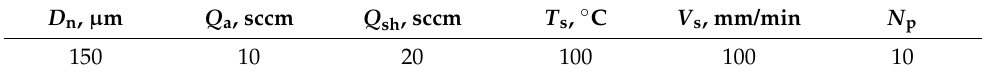
Table 2. Optimized parameters of AJP during the formation of narrow (about 30 µ m) Pt